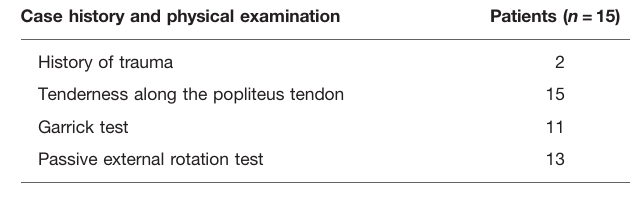
TABLE 1 | Diagnosis of popliteus